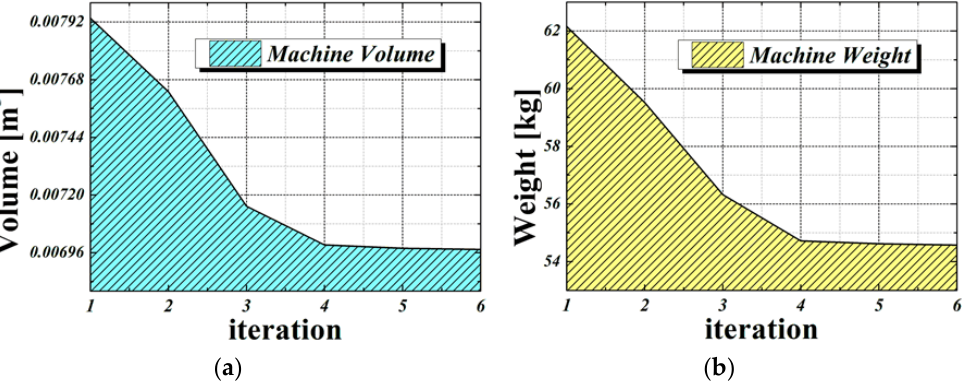
Figure 8. PMSM volume and weight optimization results according to the iteration of the optimization Table 3. Comparison of design specifications of the initial model and the optimized model.